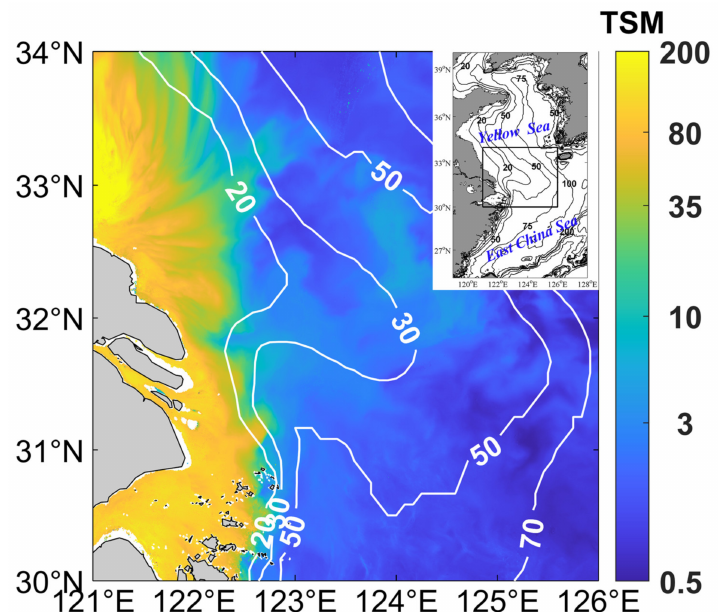
Figure 1. Composite map of 8 hourly GOCI-derived TSM (mg/L) on 13 May 2013 over the Yellow and East China Seas. The white contours indicate isobaths (in meter). The study domain is marked in the upper left